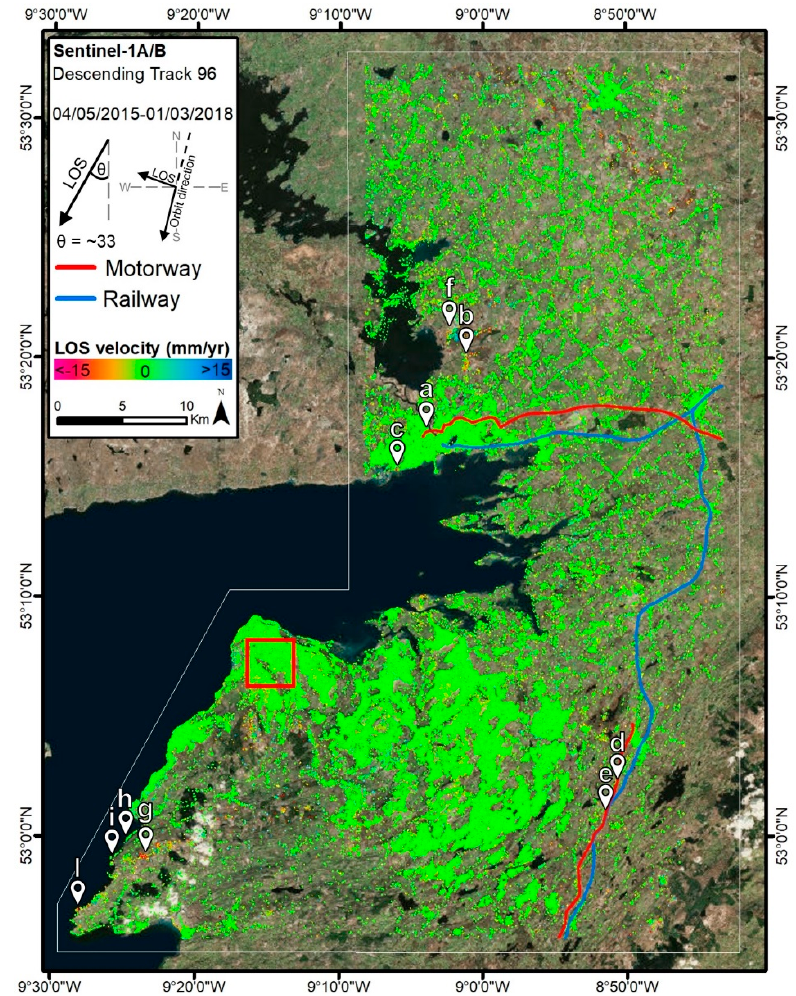
Figure 7. LOS velocity map of AOI-1 obtained from Sentinel-1A/B images with the PS-InSAR approach. SAR imagery date range: May 2015–March 2018. The sketch illustrates the satellite’s acquisition direction in respect to the orbit ( right ) and the LOS angle in respect to the vertical direction ( left ). The white pins mark the location of the selected areas described in detail in the manuscript. The red box is the area selected to extract the PSs for the statistical analysis. Base image source: Esri, DigitalGlobe, GeoEye, Earth Geographics, CNES/Airbus DS, USDA, USGS, AeroGRID, IGN, and the GIS User Community.